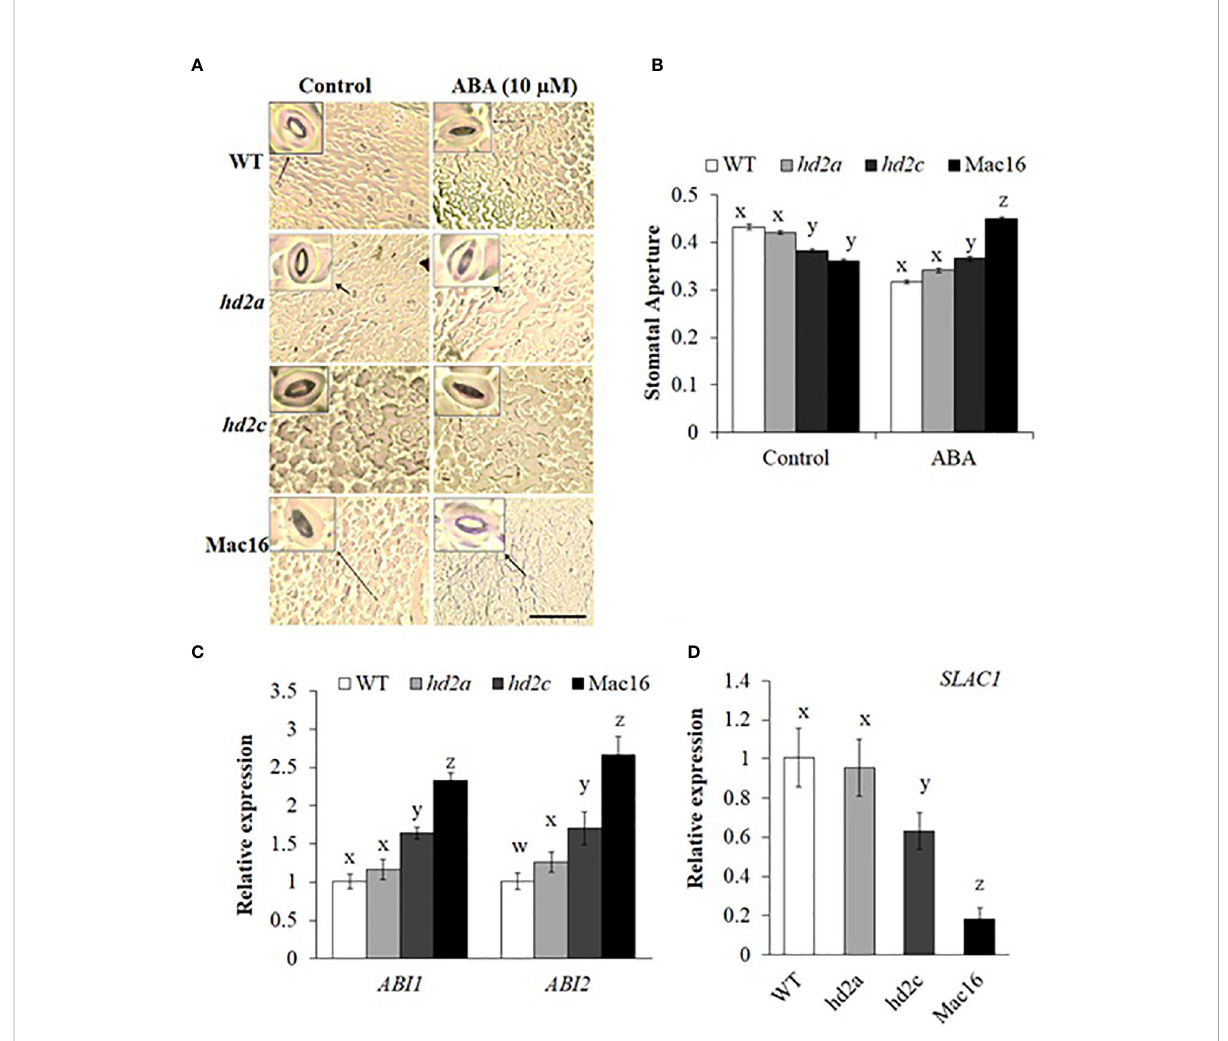
FIGURE 5 Stomatal closure and gene expression analysis under stress in hd2 mutant lines. (A) Images of stomatal pore opening and closure observed in WT, hd2a , hd2c , and Mac16 under control and ABA-induced stress (scale bar: 50 µm). (B) Stomatal aperture measured as width/length of stomatal pores in WT, hd2a , hd2c , and Mac16 under control and ABA-induced stress. Data shown are means ± standard errors from at least 150 stomata. Three independent experiments were performed in this test. In each experiment, stomatal measurements were taken from three plants of each genotype (two leaves per plant). (C, D) Relative expression of ABI1 and ABI2 (C) and SLAC1 (D) in WT, hd2a , hd2c , and Mac16 under drought conditions. Data shown are means ± standard errors (n = 3). (B-D) The signi fi cance of the differences between different genotypes was determined by one-way ANOVA followed by post-hoc Tukey ’ s HSD tests. Lowercase letters indicate signi fi cant differences (p <